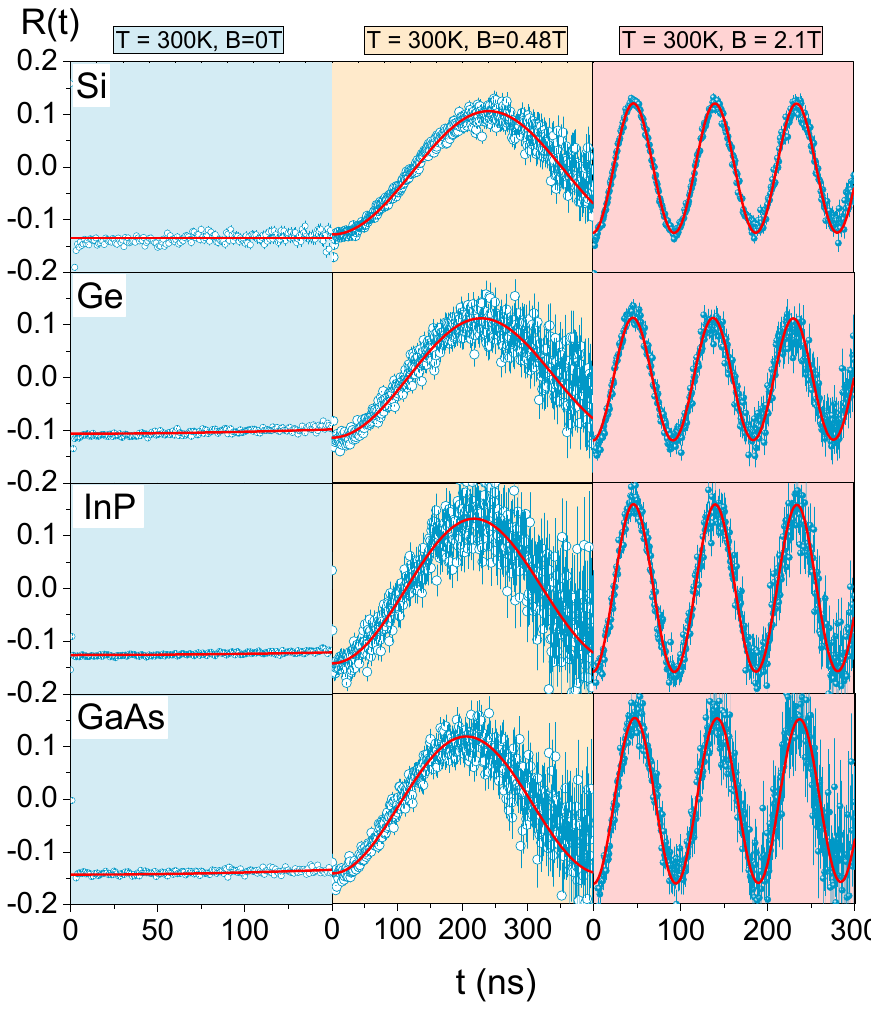
Figure 2. The fitted PAC spectra of the annealed samples in magnetic fields of 0 T (reproduced from Figure 3 in Ref. [7]), 0.48 T and 2.1 T at room temperature.